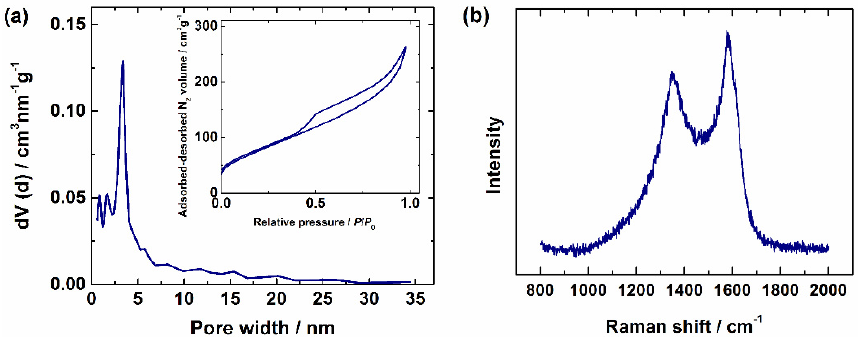
Figure 2. ( a ) Pore size distribution curve and N 2 physisorption isotherm (inset) for Glu-NC-8Co material. ( b ) Raman spectrum of Glu-NC-8Co catalyst.